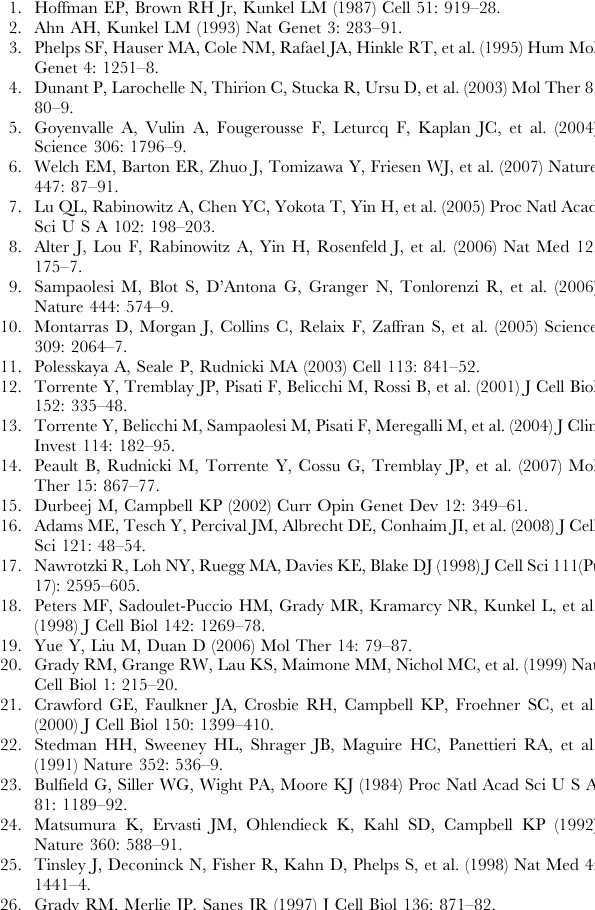
Table S1 Comparison of gene expression profiles between 4 month-old mdx and WT pectoralis muscles Table S2 Comparison of gene expression profiles between 4